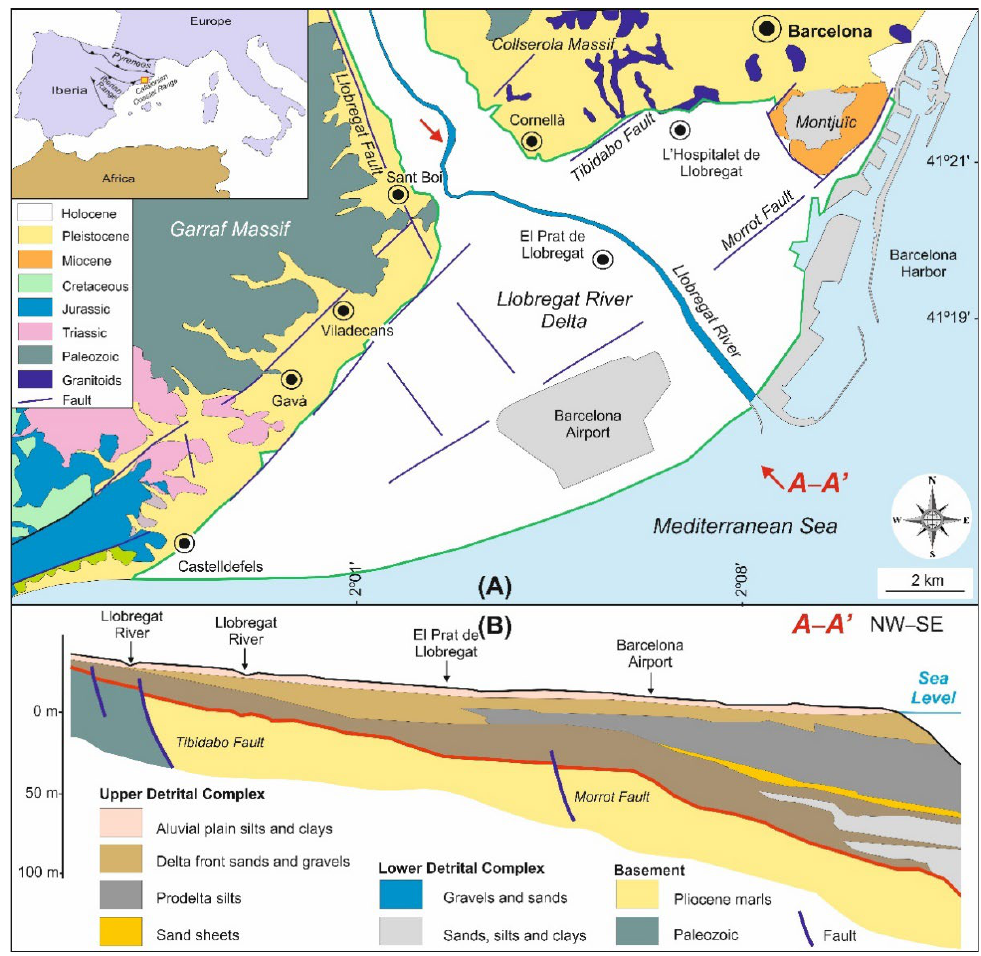
Figure 1. ( A ) Simplified geological map of the onshore LRD area (green line) updated and simplified from Medialdea and Solé-Sabarís [28,29], Almera [30] and Alonso et al. [31]. ( B ) Simplified geological cross-section A − A’ (with NW–SE orientation) of the onshore LRD; see location in ( A ).